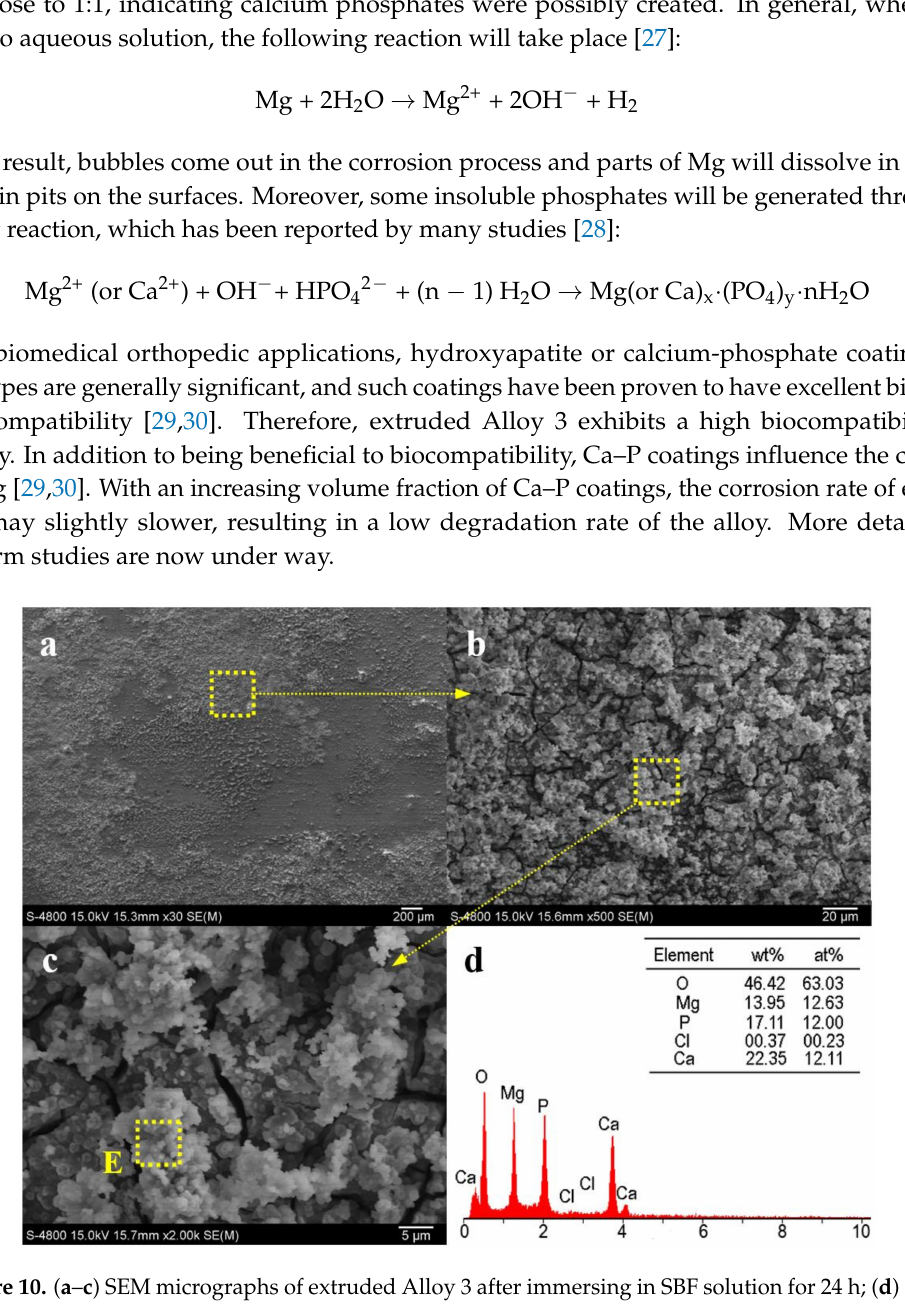
Figure 10. ( a – c ) SEM micrographs of extruded Alloy 3 after immersing in SBF solution for 24 h; ( d ) EDS analysis of area E in ( c